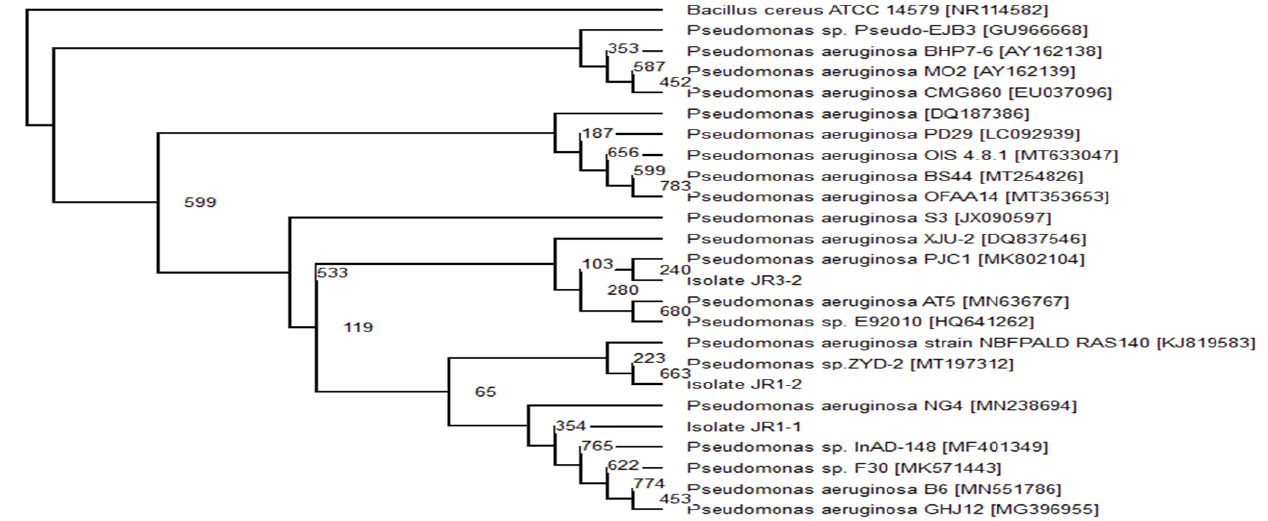
Figure 3. The cladogram was carried out based-on neighbour-joining technique illustrating the phylogenetic relationship among isolate JR1-1, JR1-2 and JR3-2 with other interconnected analogous bacterium based on 16S rRNA gene sequence examination. Bacillus cereus was the outgroup.